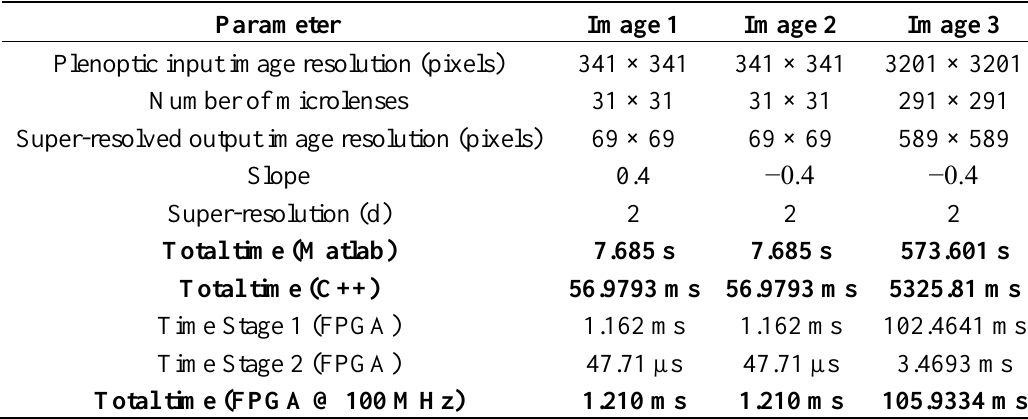
Table 1. Execution time of the algorithm in